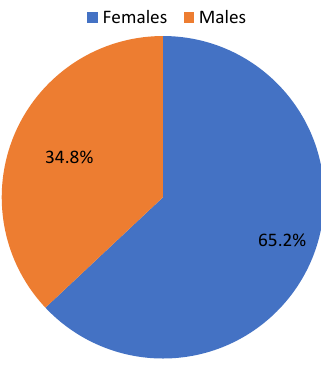
Figure 4. Sex distribution of hypertensive patients